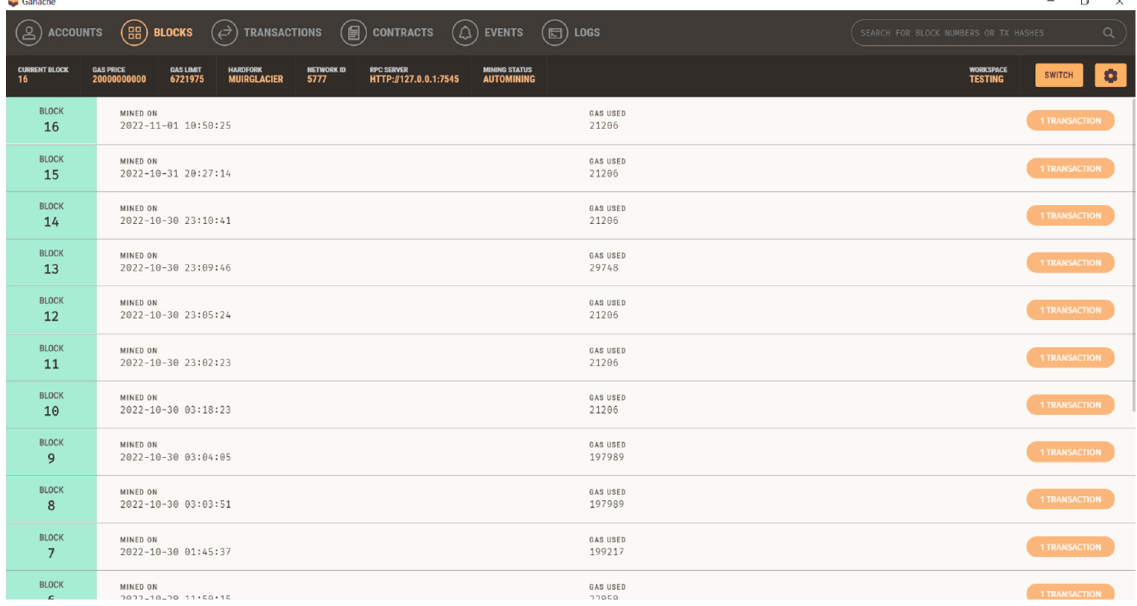
Figure 7. Blockchain transaction status on the server.